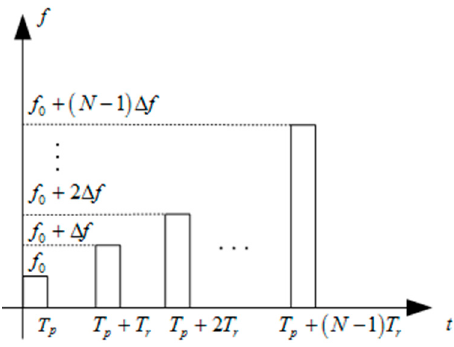
Figure 1. Scheme of the stepped-frequency signal.